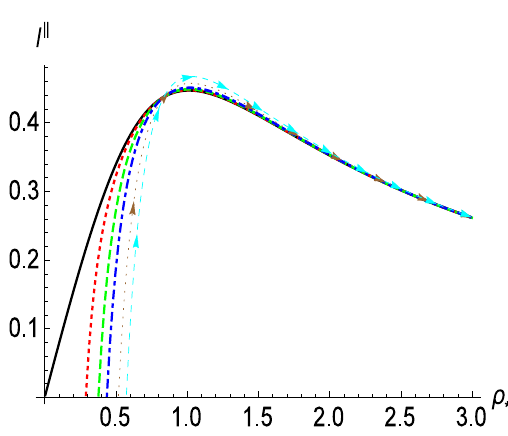
Figure 1 . ‘ k as a function of (cid:26) (cid:3) for various B , with ‘ c = 1. Here c = 2 and (solid, black), (dot, red), (dash, green), (dot-dash, blue), (arrow- dot, brown) and (arrow-dash, cyan) curves cor- respond to B = 0, 0 : 1, 0 : 2, 0 : 3, 0 : 5 and 0 : 7 respectively. In units GeV.